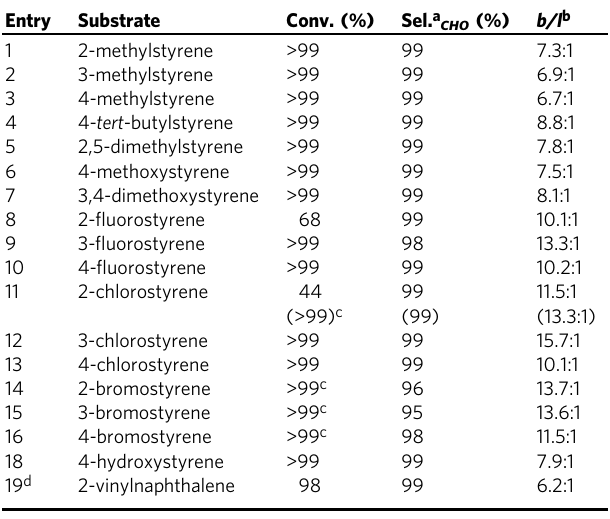
Table 2 Rh 1 /PNP-ND catalyzed hydroformylation of substituted vinyl